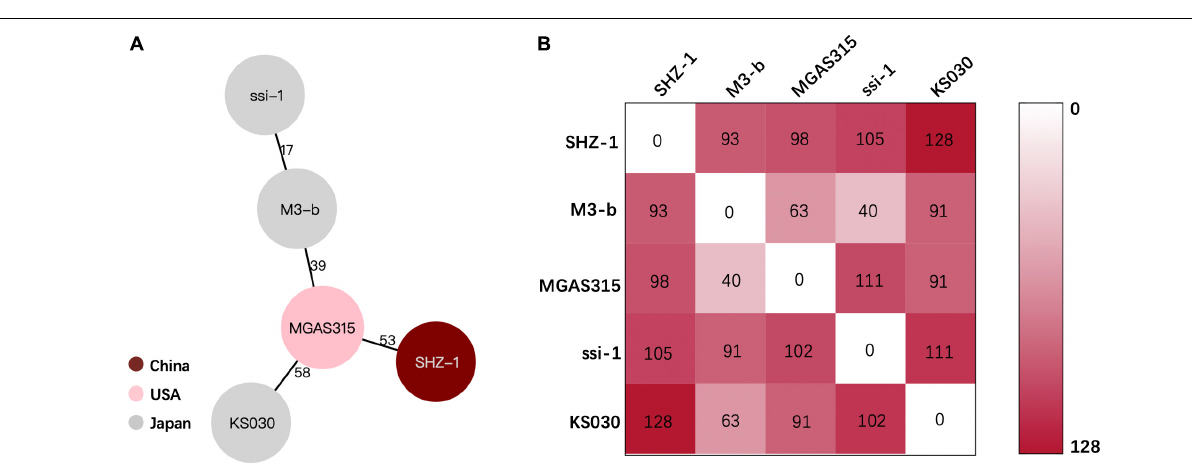
FIGURE 2 | Phylogenetic relationship between SHZ-1 and the closely related Streptococcus pyogenes strains. (A) The lines connecting the circles indicate the clonal relationship between different isolates and the digital numbers on the lines illustrate the number of allelic differences. (B) The single-nucleotide polymorphisms (SNPs) numbers between each S. pyogenes strain. The gradient of purple intensity illustrates the quantity of